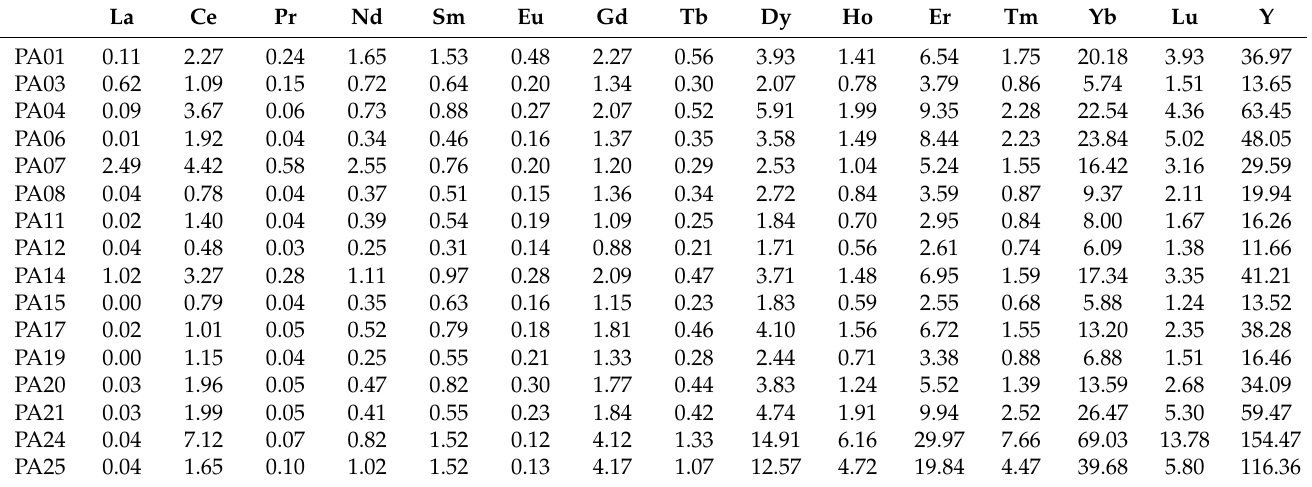
Table 3. Geochemical data for the studied